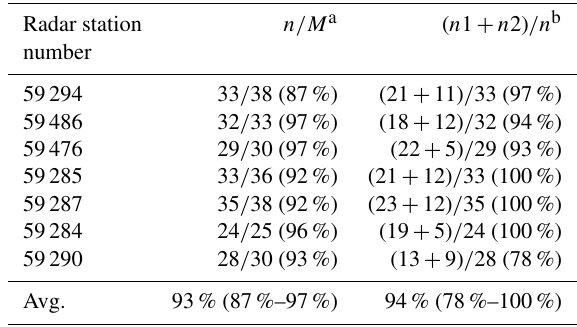
Table 2. The statistical results of the peripheral weak wind of 38 tropical cyclones for seven radar stations in Guangdong Province and ozone concentration from 2014 to